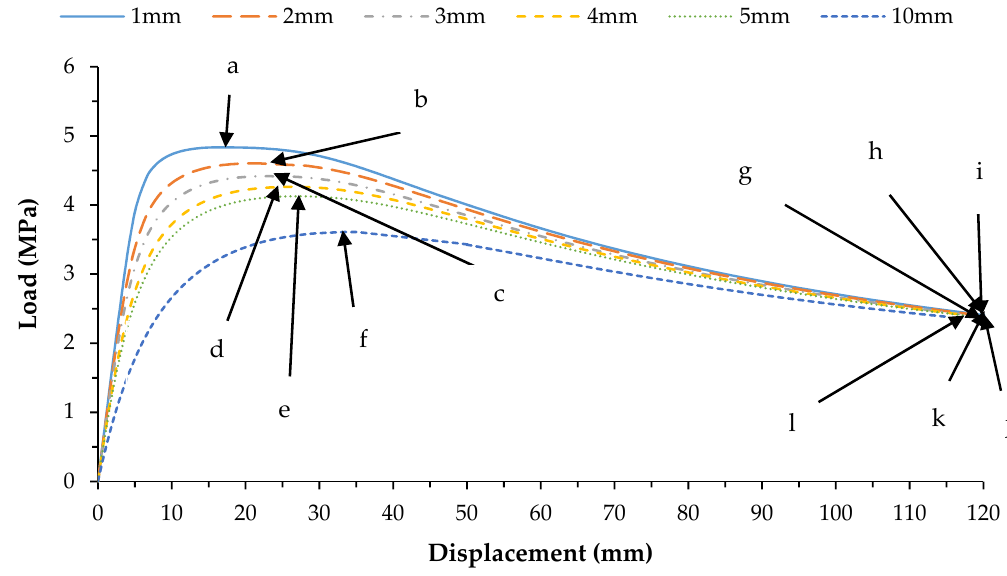
Figure 9. Load-displacement graph for all five imperfections for lowest mode imperfection.